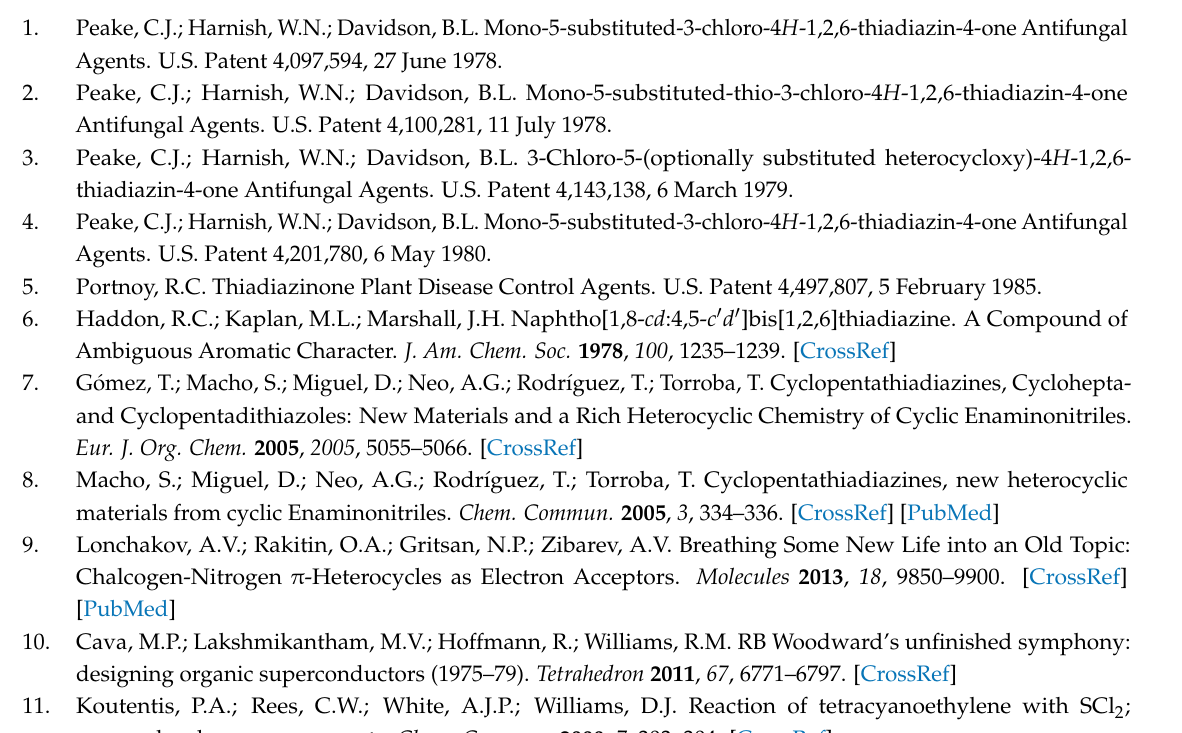
Table S3: Computational ground and excited state energy values of bithiadiazinone 7 , Figure S4: Molecular orbitals for the singlet ground state of bithiadiazinone 7 , 2D MDL molfile, 1 H and 13 C-NMR spectra of bithiadiazinone 7